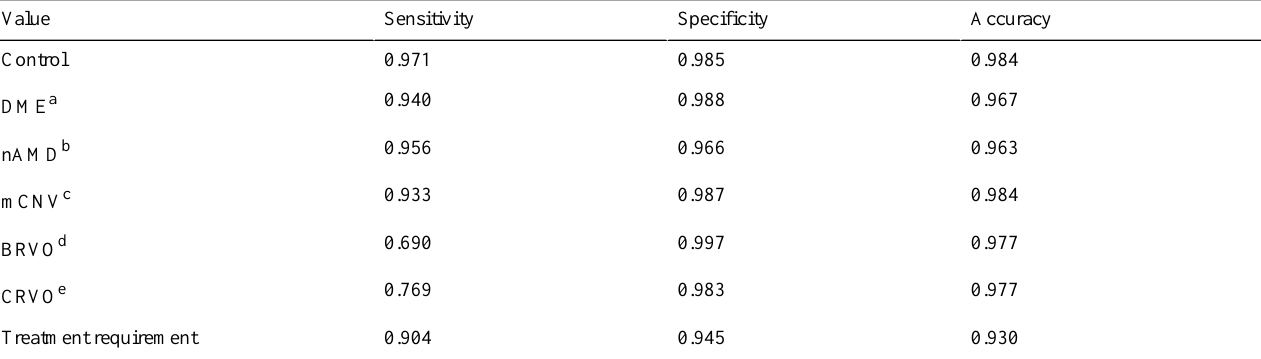
Table 3. Sensitivity, specificity, and accuracy of the model in the prediction of retinal vascular diseases and treatment-requiring diseases.